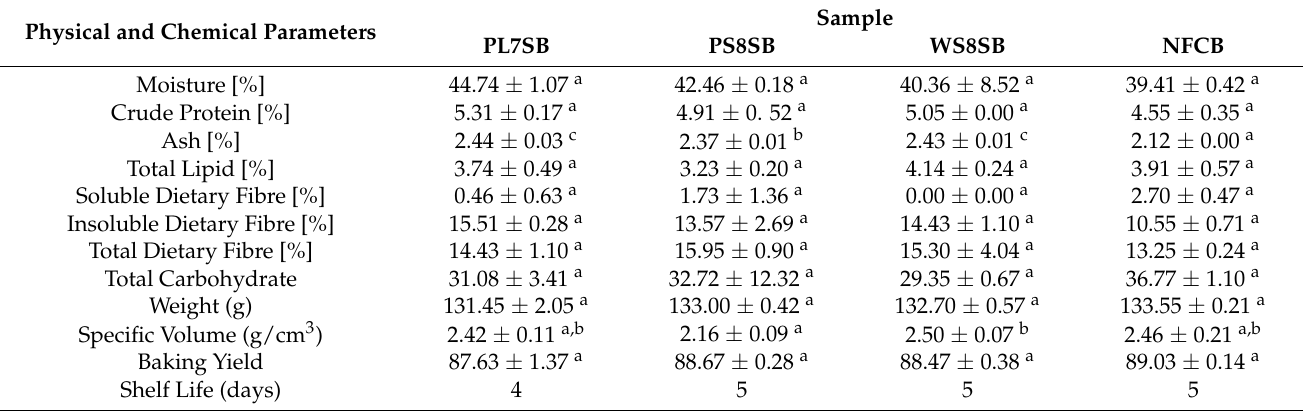
Table 3. Physicochemical parameters of sourdough breads (SB) obtained with different LAB